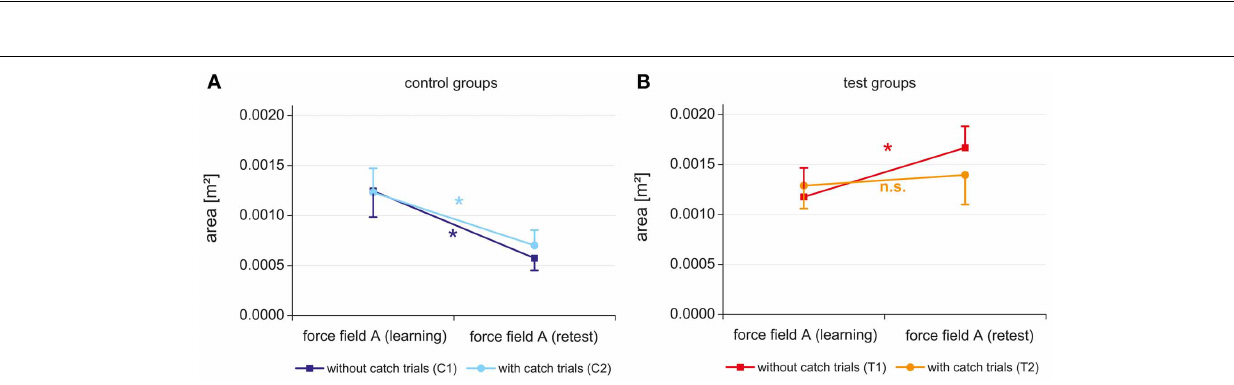
FIGURE 4 | Performance (enclosed area) during the 256 trials (without catch trials) or 208 trials (with catch trials) in force field A on day 1 (learning), force field B on day 2 (interference), and force field A on day 3 (retest) for control (A) and test groups (B) separately.